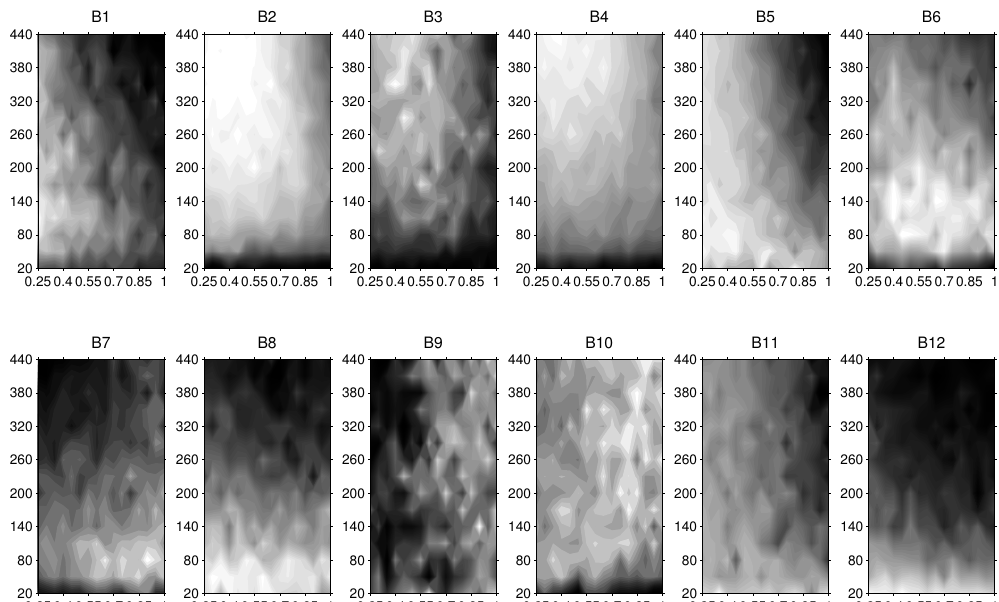
Fig. 3. ESN cross-validation performance (averaged over 10 runs) over a range of values for the reservoir size (y-axis) and spectral radius (x-axis). Lighter shades represent a low MSE, darker shades a high